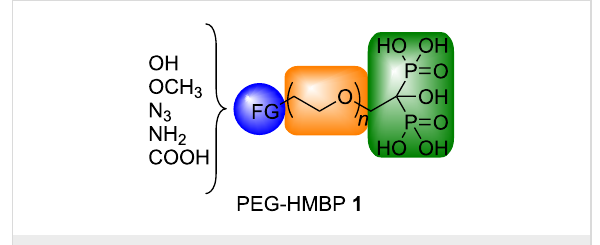
Figure 1: Bifunctional PEG-HMBPs 1